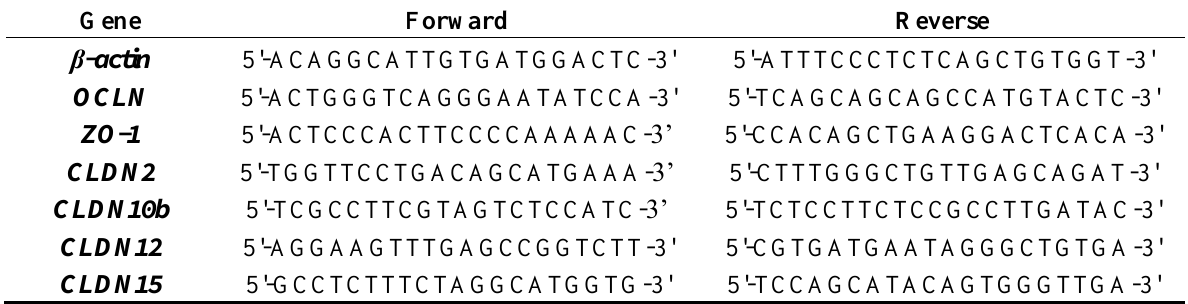
Table 3. List of primers used for polymerase chain reaction (PCR) in this study. Gene